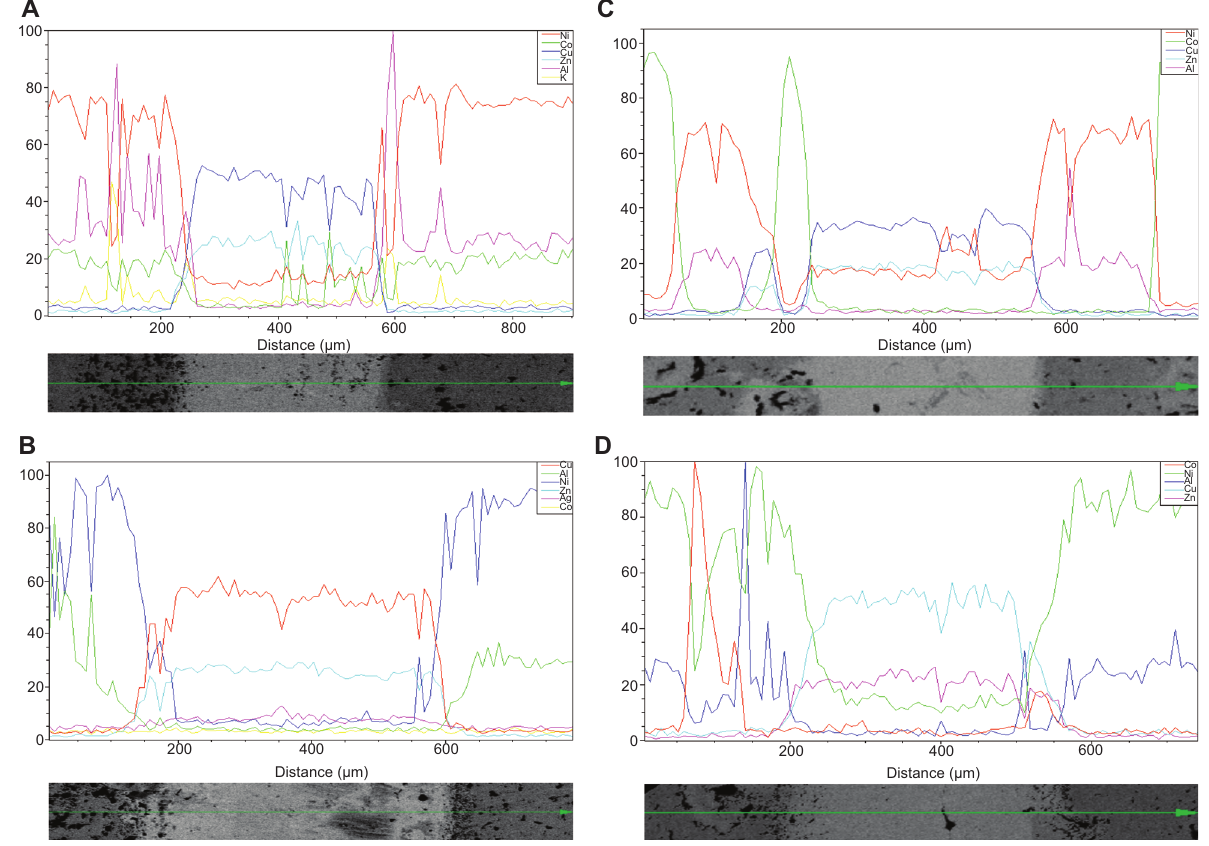
Figure 9 EDX line analysis images from Ni+Al+% 15 Co brazed for 15 min. (A) Traditional furnace with a S2 brazing alloy; (B) traditional furnace with a S28 brazing alloy; (C) microwave furnace with a S2 brazing alloy; (D) microwave furnace with a S28 brazing